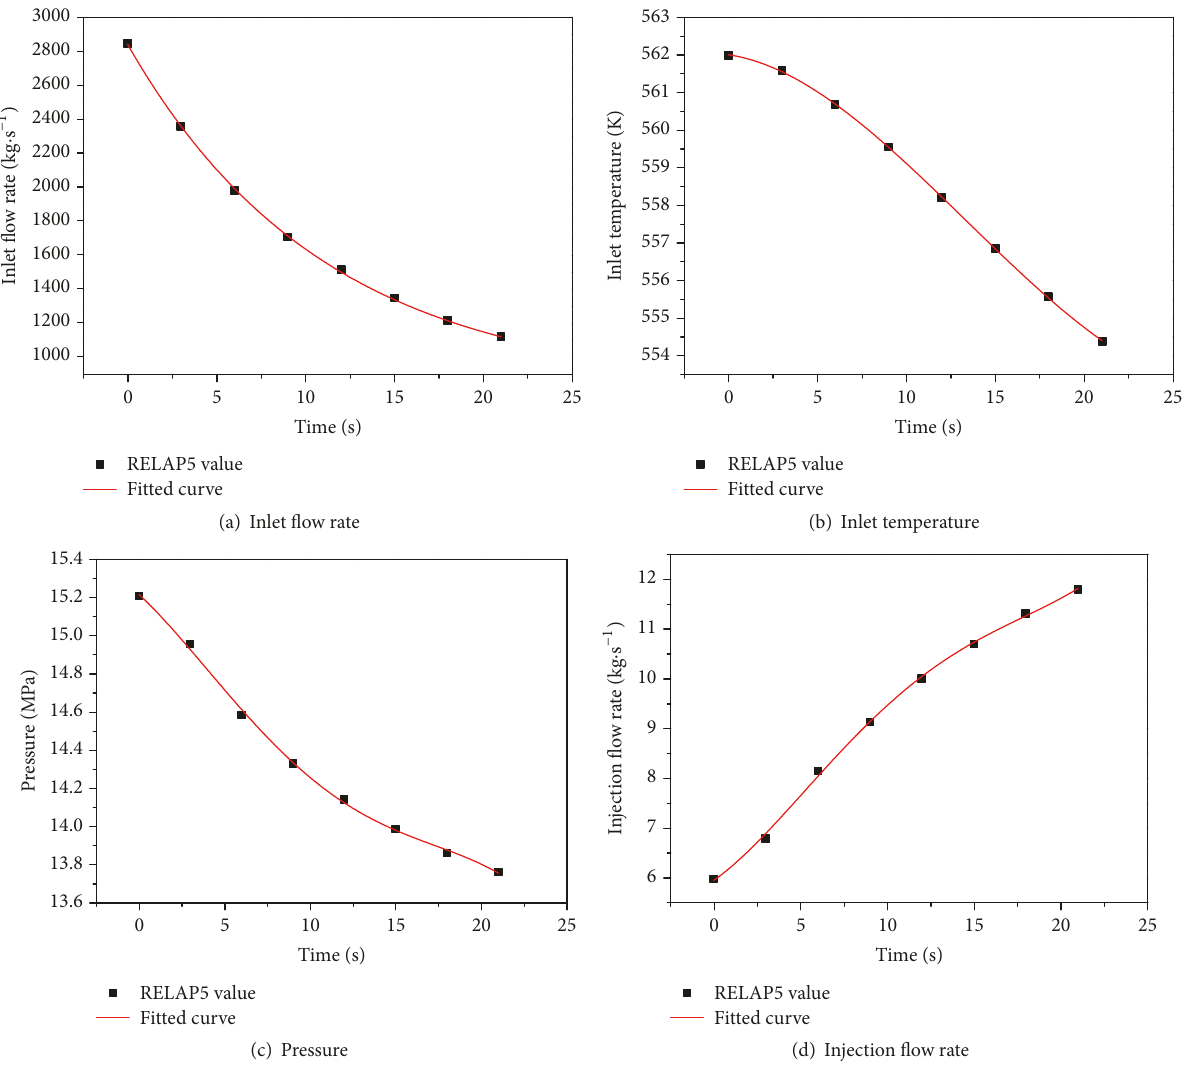
Figure 10: Fitted boundary conditions from 102 s to